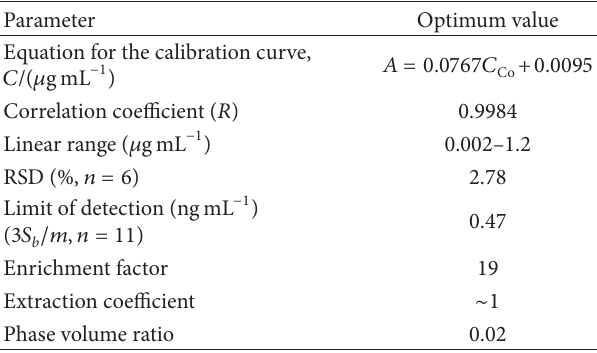
T 2: Characteristics performance ofthepresented CPEmethod. Parameter